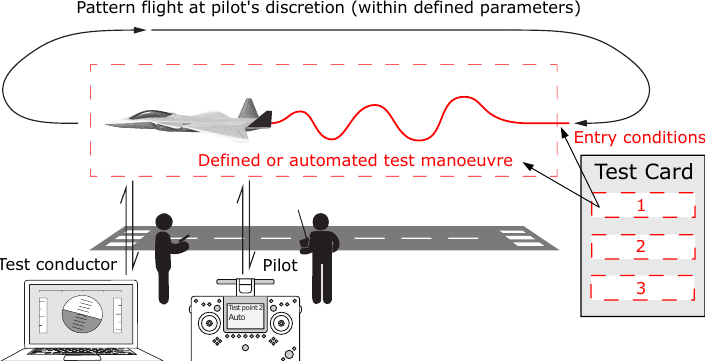
Figure 8. A more practical approach to SFT planning at levels 1 and 2: only entry conditions and manoeuvres inside the test window are scripted in detail.